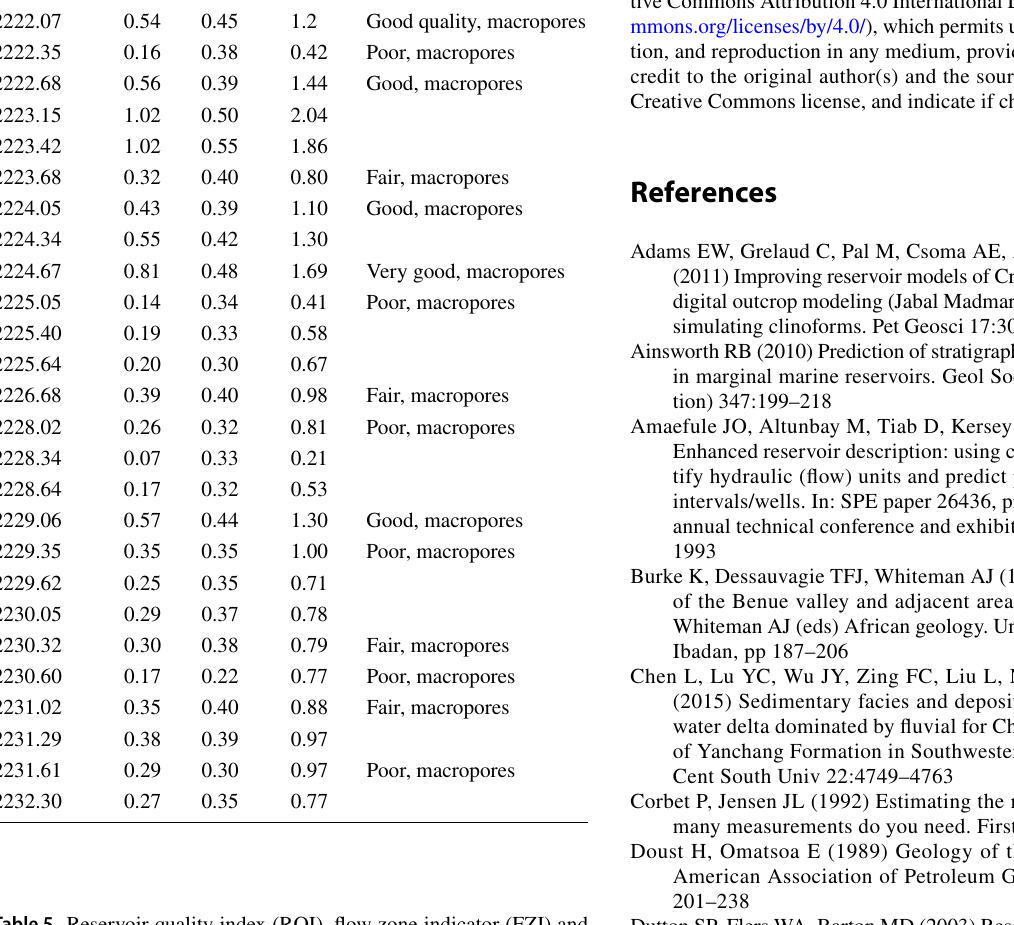
Table 5 Reservoir quality index (RQI), flow zone indicator (FZI) and pore matrix ratio (PMR) of PZ-4 well, Niger Delta Sample depth (m)